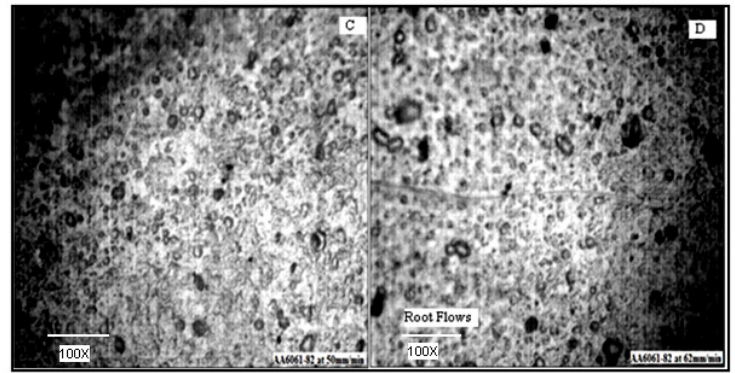
Figure 7: Optical micrograph of AA6082-6061(A) at 50mm/min (B) at